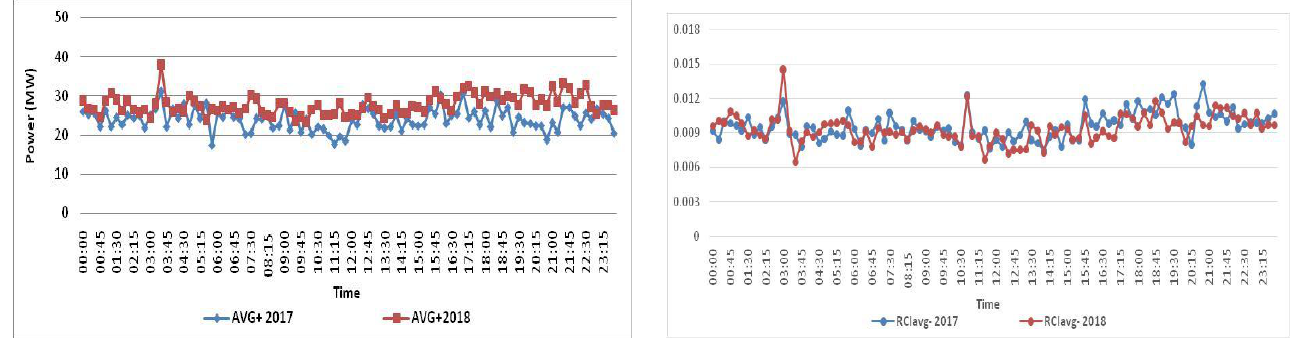
Figure 11. Comparison between RCIs for the average of downward power ramps in 15 min interval at each observation time t for the years 2017 and 2018.